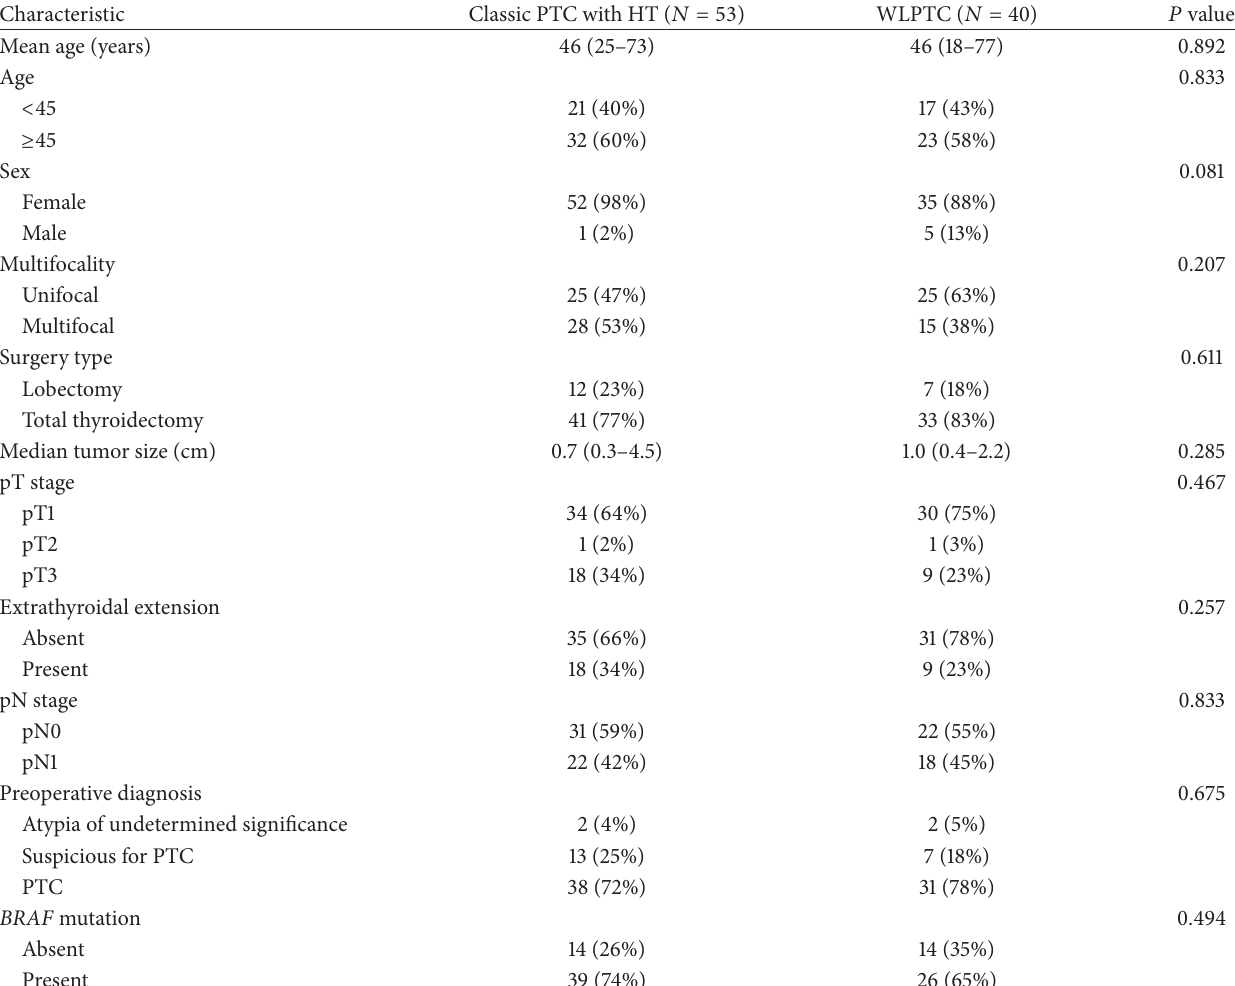
Table 3: Comparison of clinicopathologic characteristics between WLPTC and classic PTC coexisting with HT.